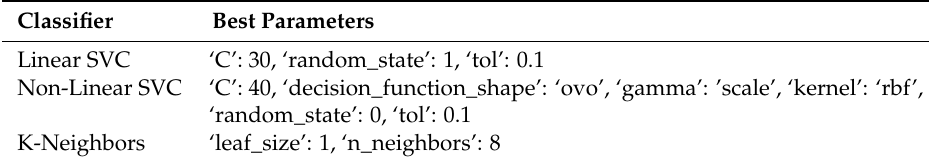
Table A1. Best hyper-parameters for the trained models.